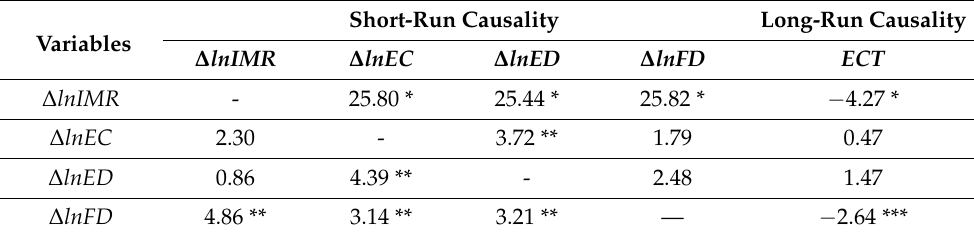
Table 9. Causality Results for Health Outcomes (Infant Mortality).